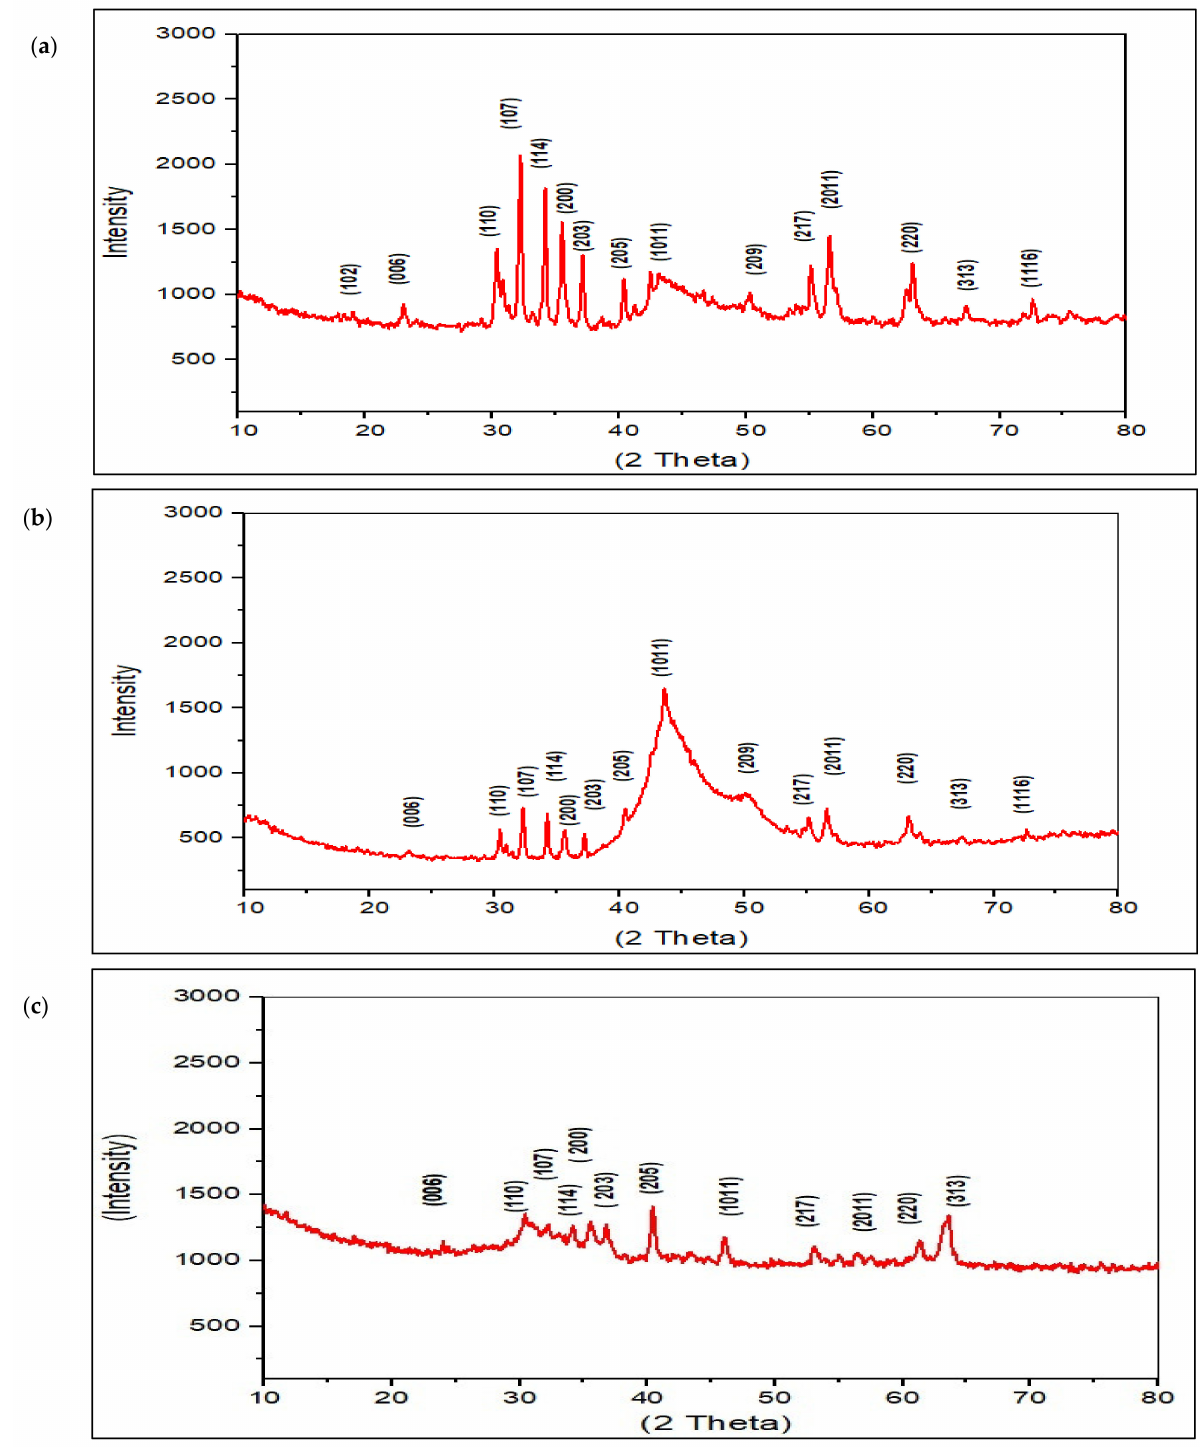
Figure 7. XRD of ( a ) Sintered sample at the optimized parameters; ( b ) Sintered sample at the initial parameters, and ( c ) Starting powder used in this